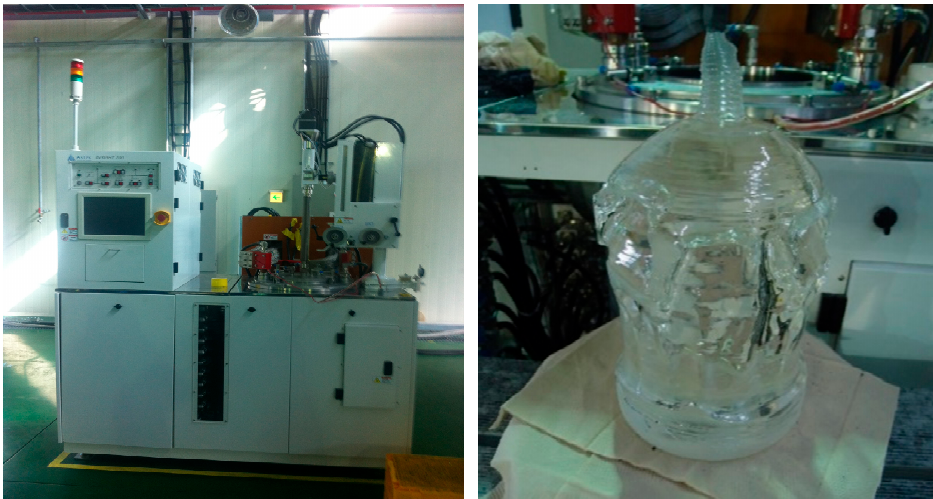
Figure 7. The single crystal growth of sapphire using the Ky method.